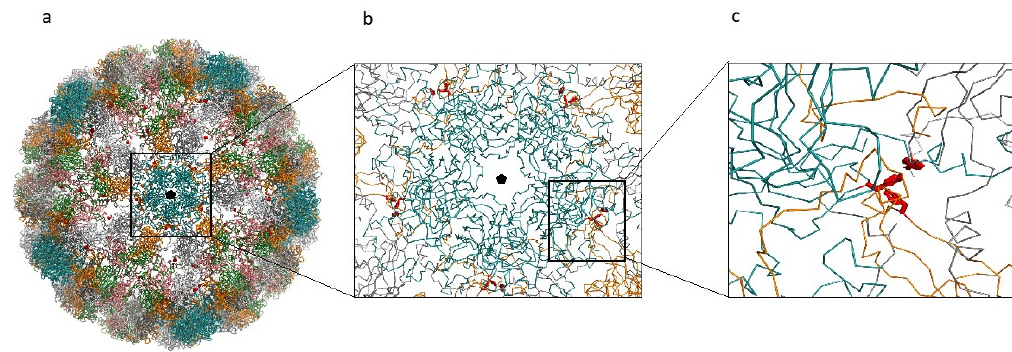
Figure 7. MCPyV capsid reconstruction. ( a ) MCPyV capsid reconstructed from the 6ZLZ coordinate set. The capsid is oriented with the fivefold axis of symmetry (black pentagon) perpendicular to the view. VP1 proteins of the capsid are represented as α -carbon trace and colored according to the different chains. Blue capsomers are the α -pentamers located at the vertices of the capsid icosahedron. Side-chains of the mutant Phe residues are displayed as red sticks. ( b ) Detail of the interactions between the α -pentamer and the neighboring capsomers. ( c ) Detailed view of one of the Phe clusters created by the mutation